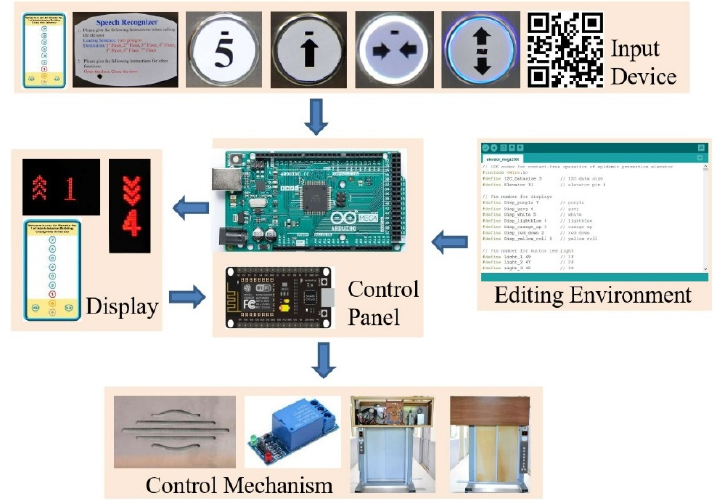
Figure 11. Architecture of contact-free epidemic prevention elevator.